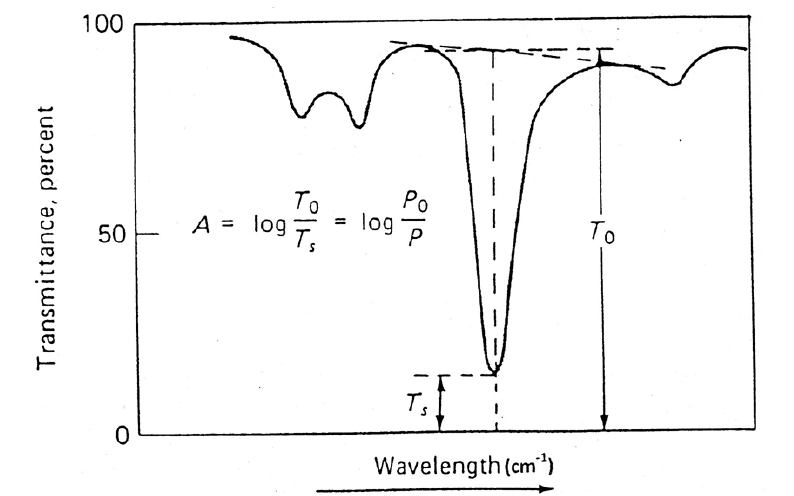
Figure 8. Baseline method for determining absorbance from infrared